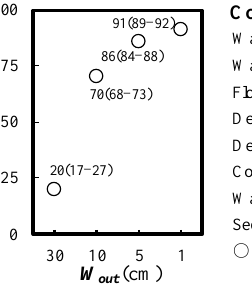
Figure 16. Effects of the change in the downstream opening width of the sediment retarding basin on the wood debris capture rate.